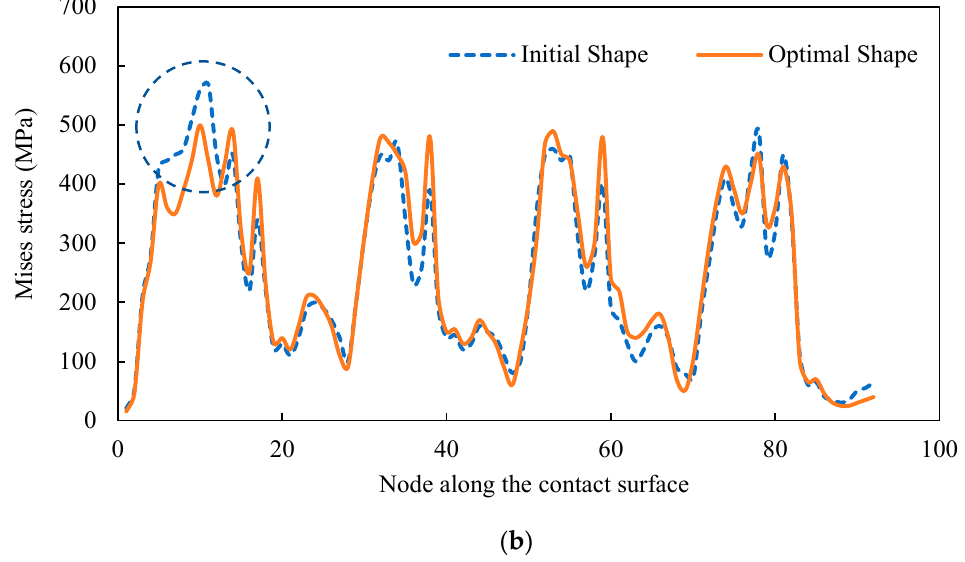
Figure 8. Stress distribution along face of blade side and rotor side. ( a ) Stress distribution along face of blade side, ( b ) Stress distribution along face of rotor side.